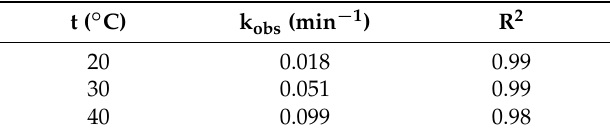
Figure 6. Effects of temperature on the PMS/CoMgAl-LDH system during phenol degradation. ( A ) Different temperature, ( B ) ln(C/C 0 ) versus reaction time.